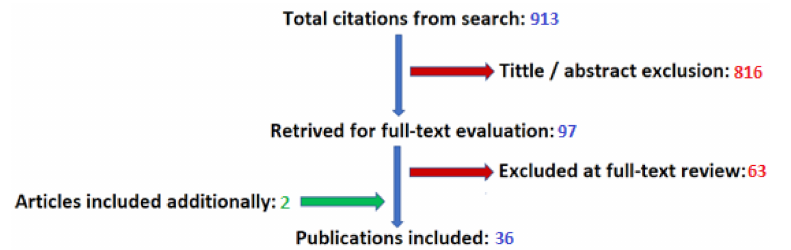
Figure 1. Results of literature